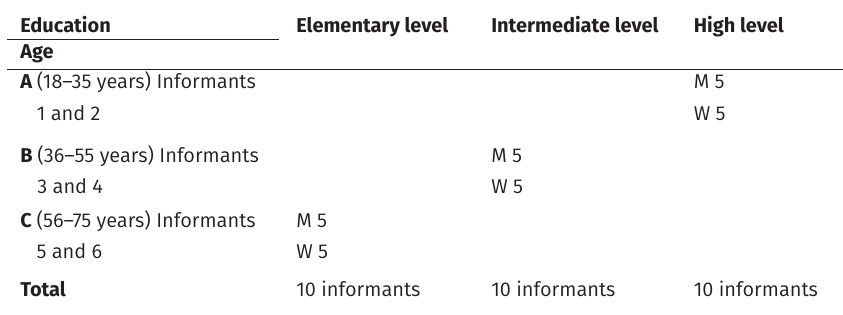
Table 1: Sociocultural characteristics of the